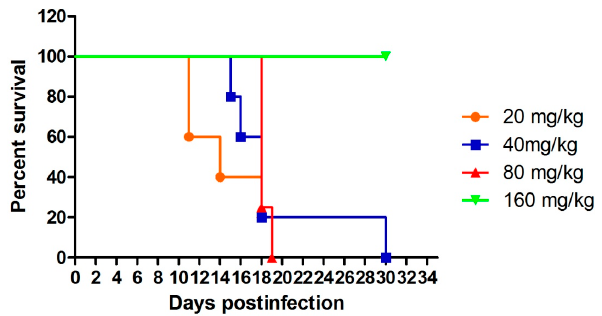
Figure 3. Effect of treatment with compound 1 at four dosage regimens (20, 40, 80, 160 mg/kg) on the survival of mice infected with P. berghei Antwerpen-Kasapa (ANKA) strain.